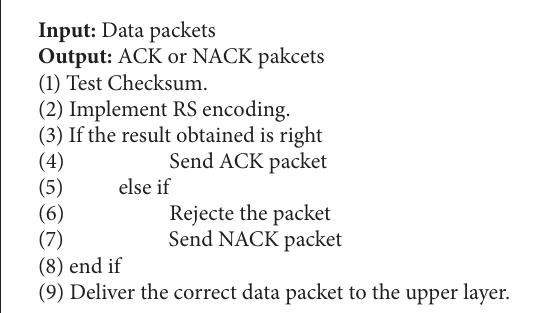
Algorithm 3: Algorithm of ACFEC at receiver node.